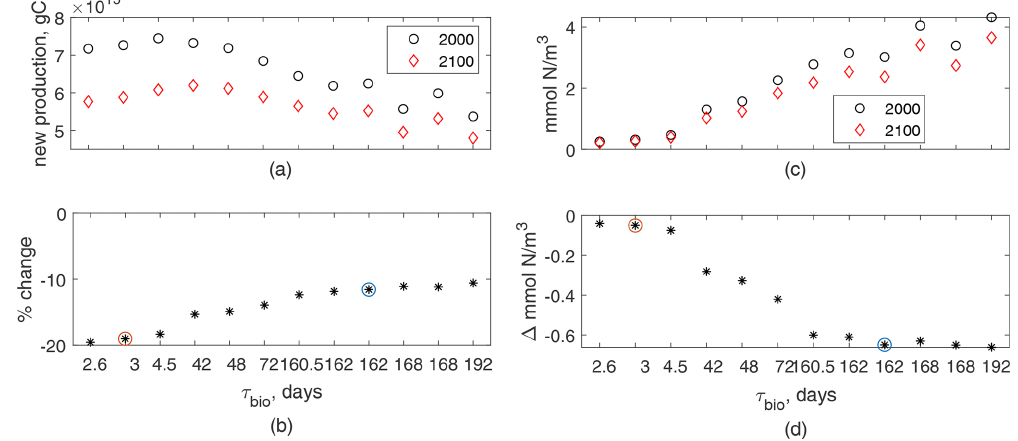
Figure 3. (a) Global annual new production integrated over the top 100m for 12 cases for 2000 (black circles) and 2100 (red diamonds) vs. τ bio (nonlinear axis for readability). (b) Percent change from panel (a) , black stars; fast and slow cases circled in orange and blue, respectively. (c) Global mean N in the top 100m vs. τ bio . (d) Absolute change from panel (c)